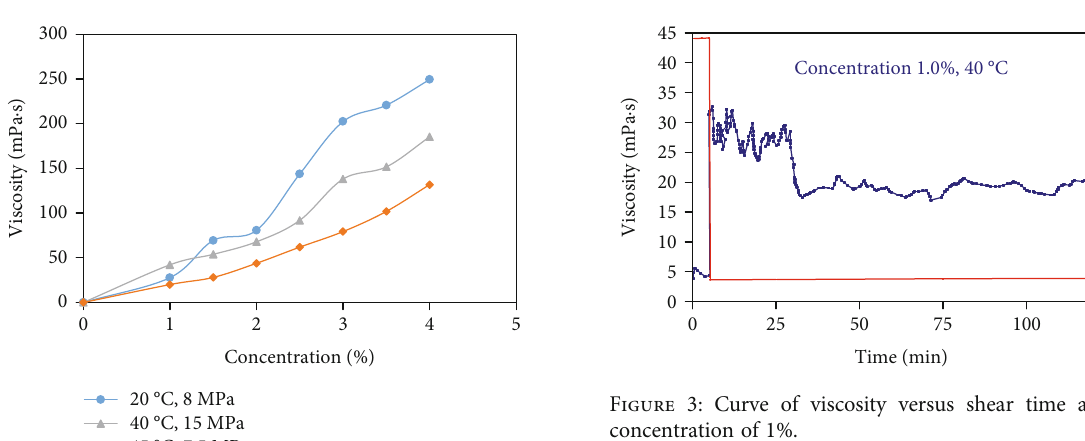
fracturing fl uid. 2